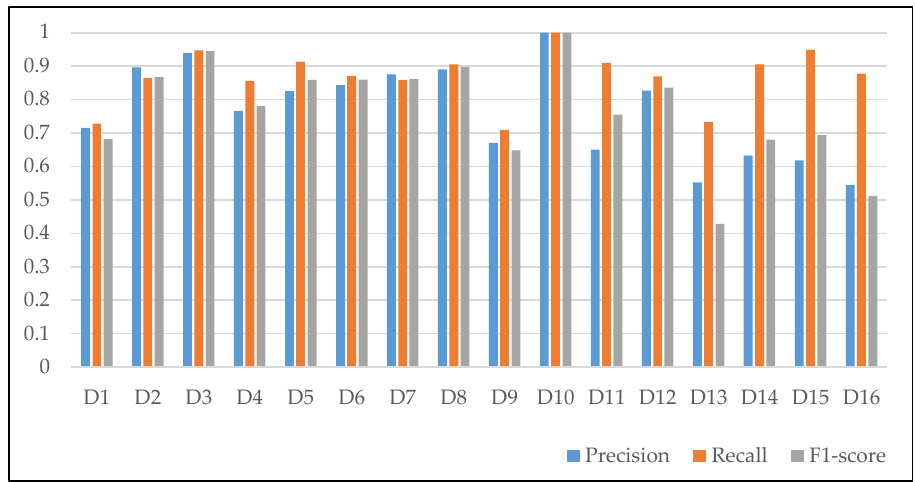
Figure 6. Precision, Recall, and F1-score for the overall samples of 16 datasets.